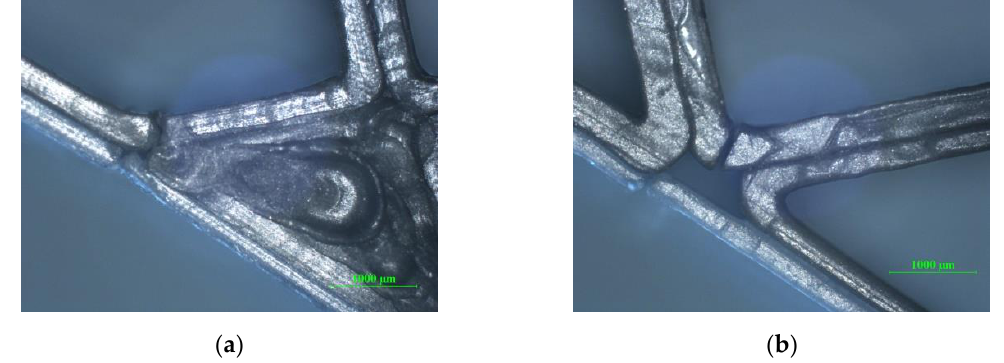
Figure 15. Optical micrographs of failed sandwich specimens subjected to tensile tests (magnification 25X): ( a ) honeycomb core sandwich specimens; ( b ) diamond-celled core sandwich specimens.